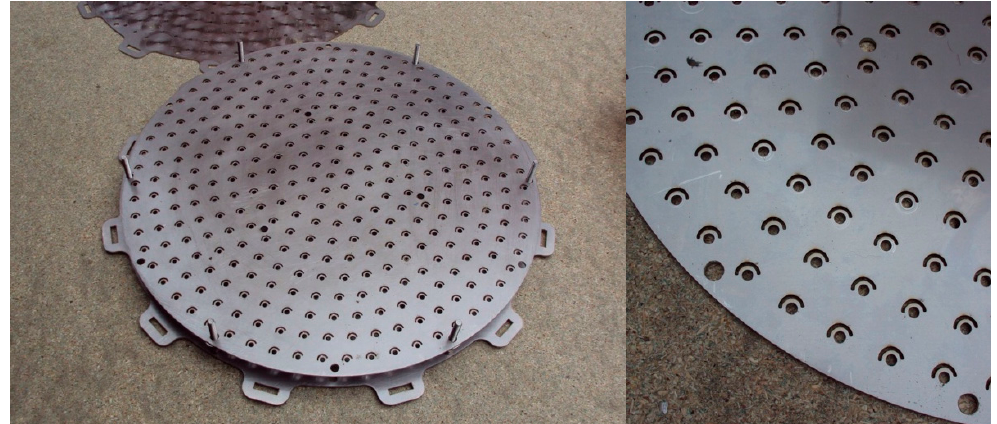
Figure 4. Attempt to address issues with the initial pin friction locking approach. This was attempted to be resolved as integral spring elements implemented as semicircular cuts around the holes in the central pin matrix plate, (photos: Jorgensen, T. 2012).